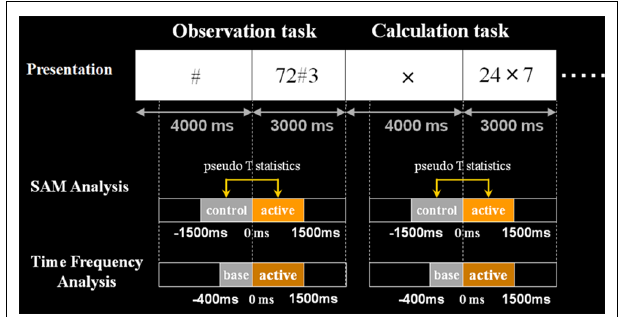
FIGURE 4 | Schematic diagram of the second experimental paradigm. This figure shows the schematic diagram of the task presentation and analyses the time window. First, in control stimuli, we presented X, # or VOICE for 4 s, which means what the subject should do in active stimuli. Then, in active stimuli, numbers for calculation were presented for 3 s. In SAM analysis, we compared 1.5 s before and after the presentation of numbers. Also, regarding time-frequency analysis, the baseline was set for 400 ms before the number presentation. Analyzed frequency bands are as shown here.